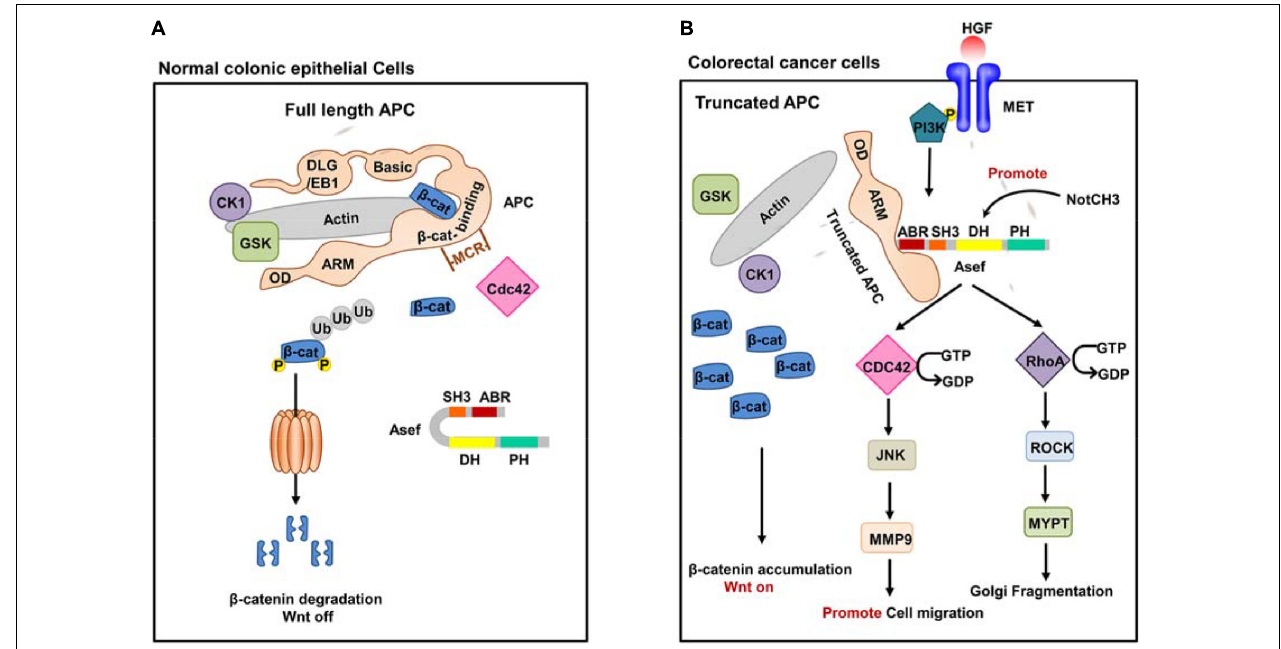
FIGURE 2 | The function of Wile-type APC and truncated APC. (A) Wild-type full-length APC in normal colonic epithelial cells. In normal colonic epithelial cells, APC acts as a tumor suppressor in the traditional Wnt signaling pathway. APC could interact with β -catenin and form APC/Axin/GSK3- β destruction complex. The destruction complex promotes phosphorylation of β -catenin and induces its proteasome-mediated degradation, thus suppressing the canonical Wnt signaling pathway. (B) A representative truncated APC in CRC cells. In CRC cells, truncated APC interacts with Asef instead of β -catenin and stimulates the GEF activity of Asef. Activated Asef promotes cell migration and Golgi fragmentation through the downstream